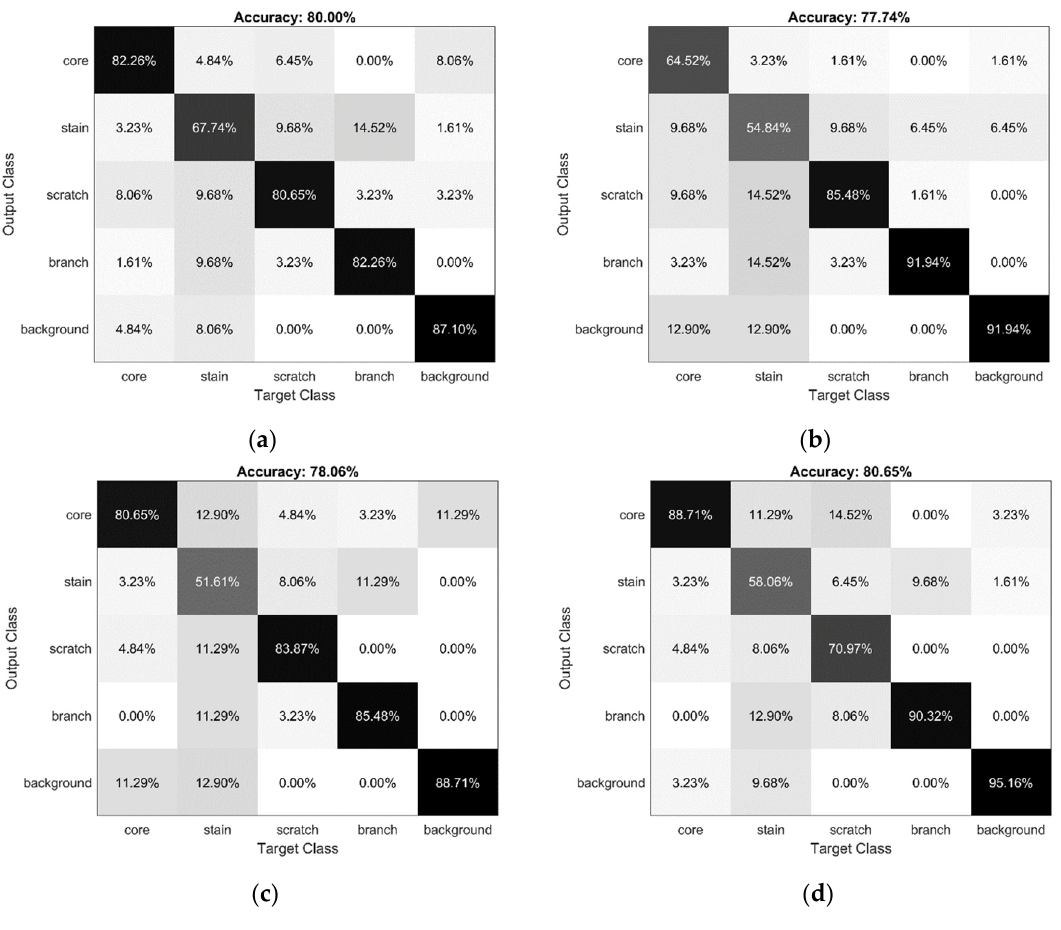
Figure 16. Classification accuracy using ResNet152 neural network trained with different network parameters (batch size and learning speed). The best combinations of parameter values are indicated in red.